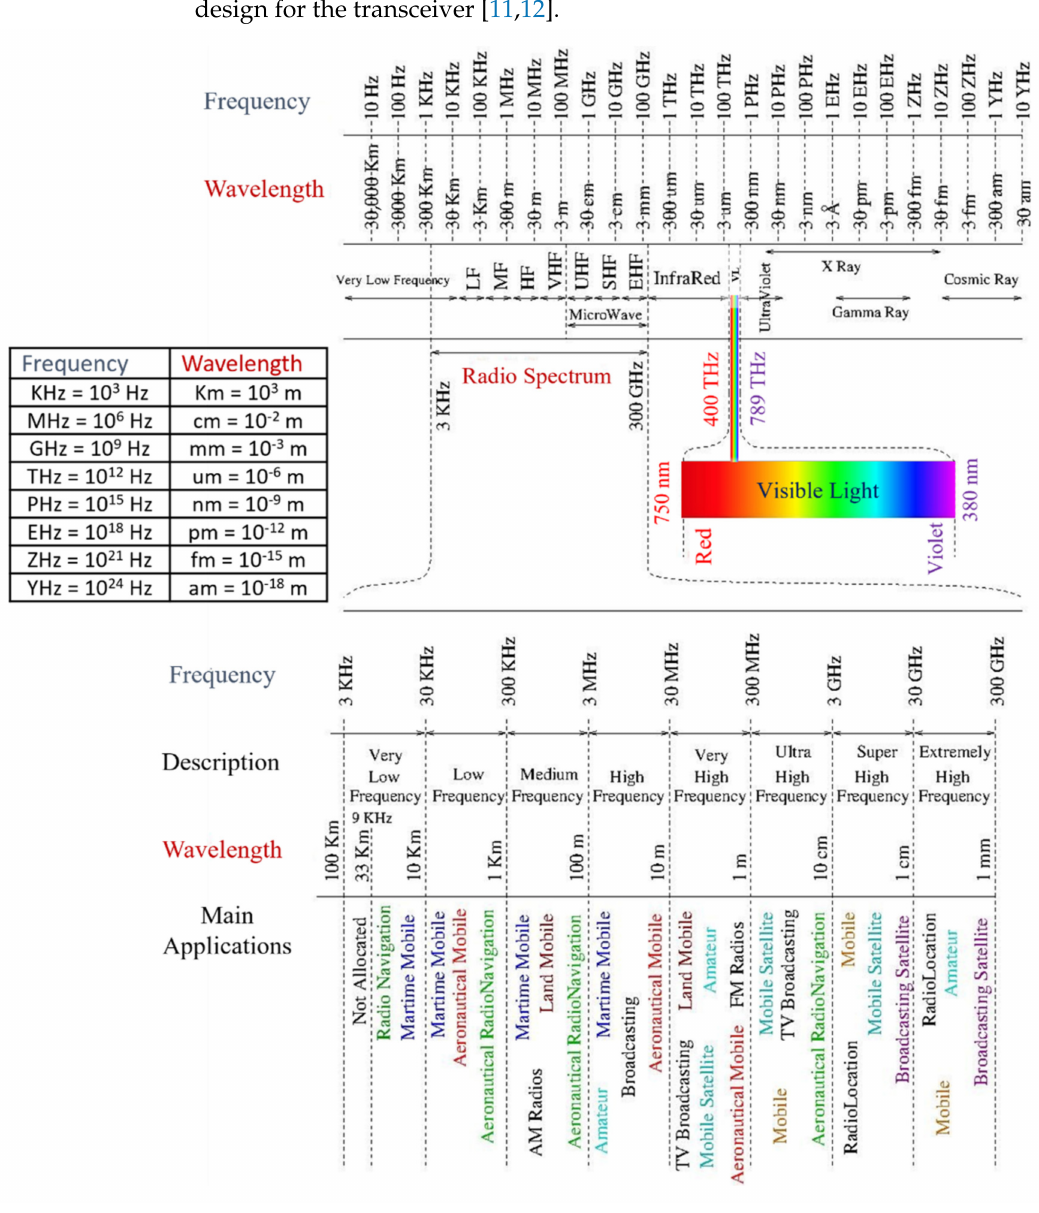
Figure 1. Spectrum allocations, according to their wavelengths λ , frequencies F and applications. This figure is based on an initial figure shown in our previous work